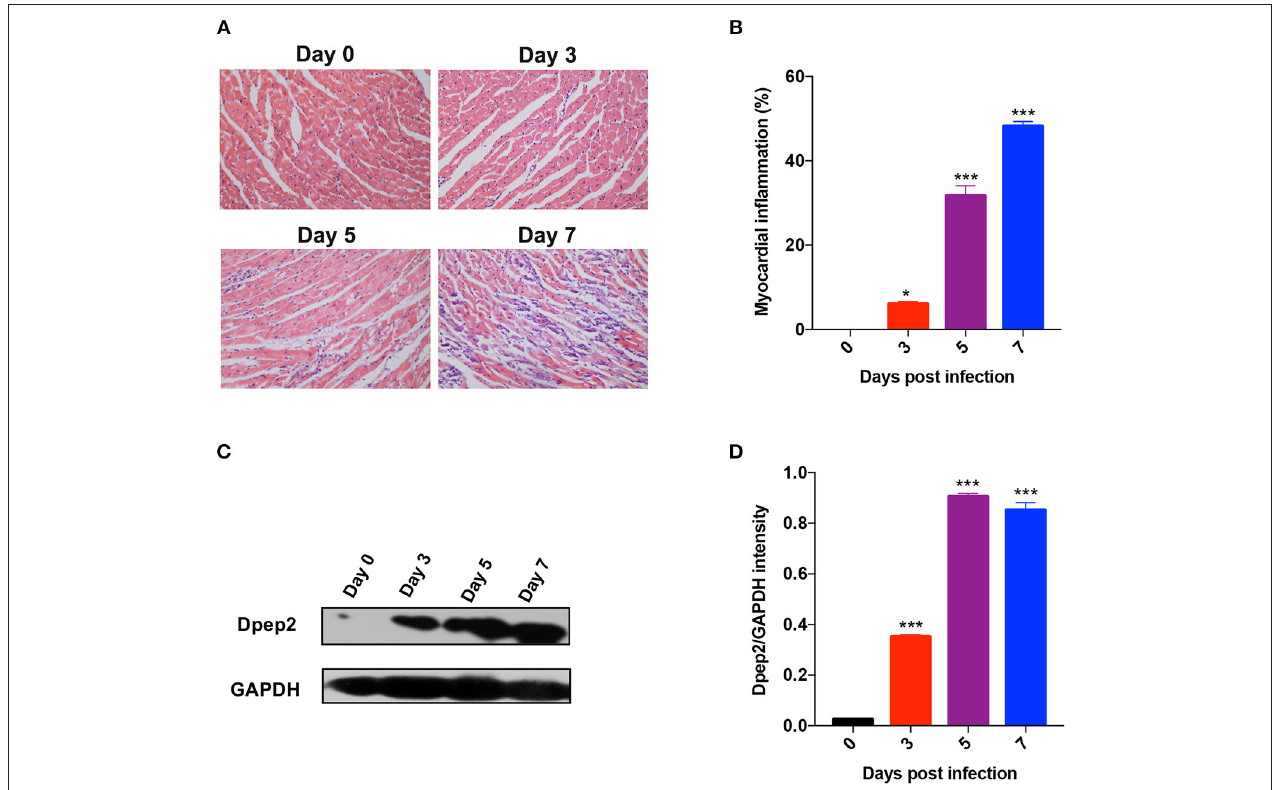
FIGURE 1 | Dpep2 was significantly increased in viral myocarditis (VMC). Male BALB/c mice were intraperitoneally injected with 10 3 PFU CVB3 and the heart tissues were collected at the indicated time points. Myocarditis severity was evaluated by (A) pathological observation (magnification: 200 × ) and (B) percentage of myocardial inflammation. (C) Myocardial Dpep2 kinetics during CVB3 infection were detected by Western blot. (D) Band intensities were quantified by ImageJ software and normalized to GAPDH. Individual experiments were conducted three times with similar results and the representative data were shown. Data